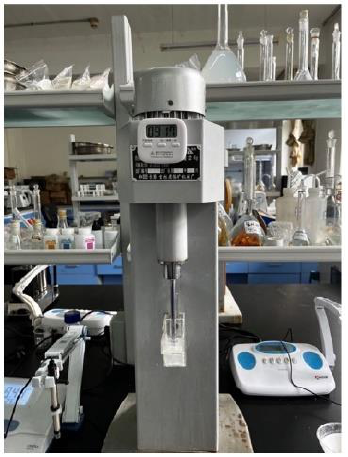
Figure 2. XFG flotation machine used for the flotation tests.